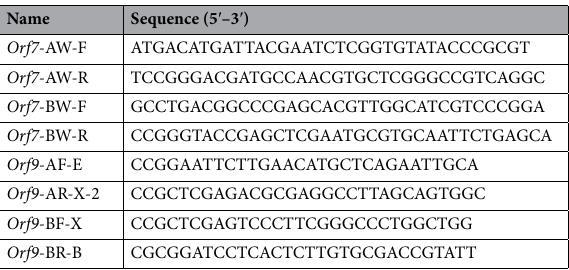
Table 1. PCR primers used in this